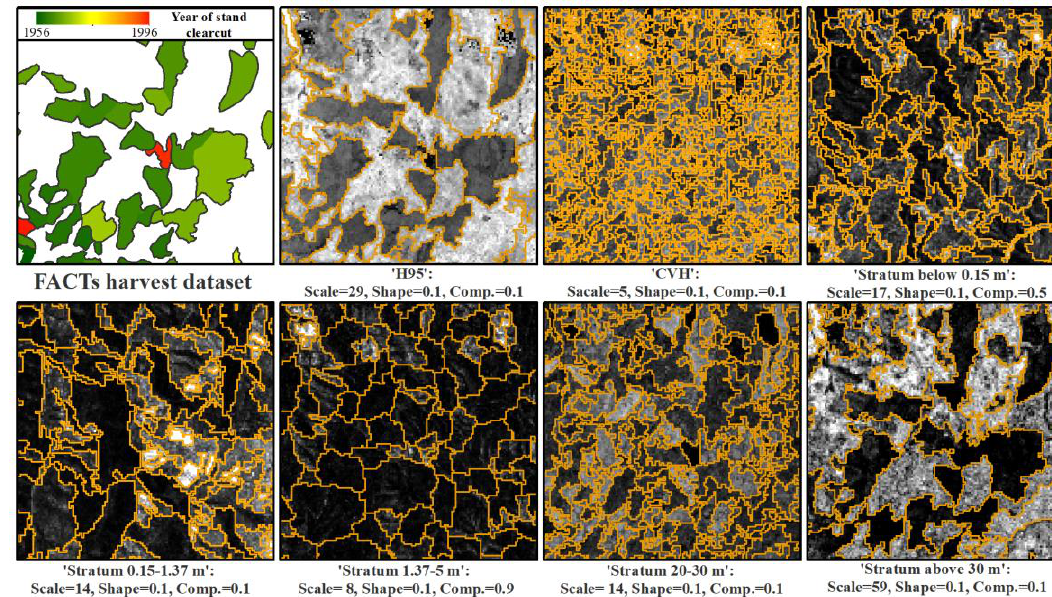
Figure 8. Optimal segmentation of the seven considered LiDAR metrics, shown for the same 4 × 4 km subset of Figure 1. The FACTS harvest reference dataset is shown at the upper left for comparison.